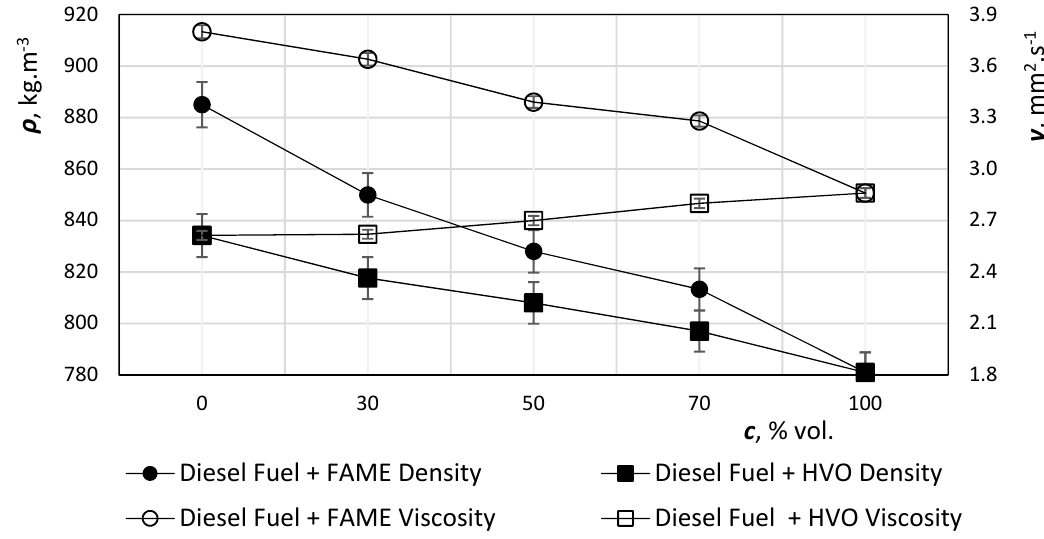
Figure 4. Density and kinematic viscosity of diesel fuel with FAME and hydrotreated vegetable oil (HVO).